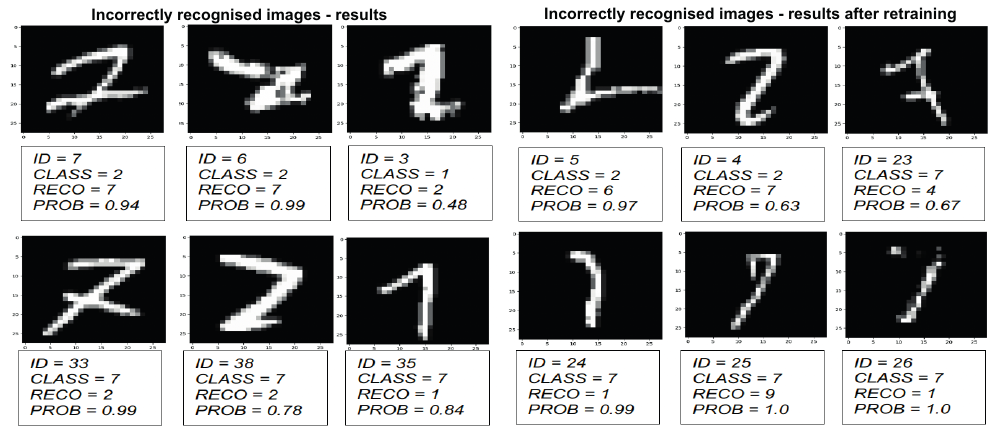
Figure 10. Details of incorrectly recognized test images after initial and second